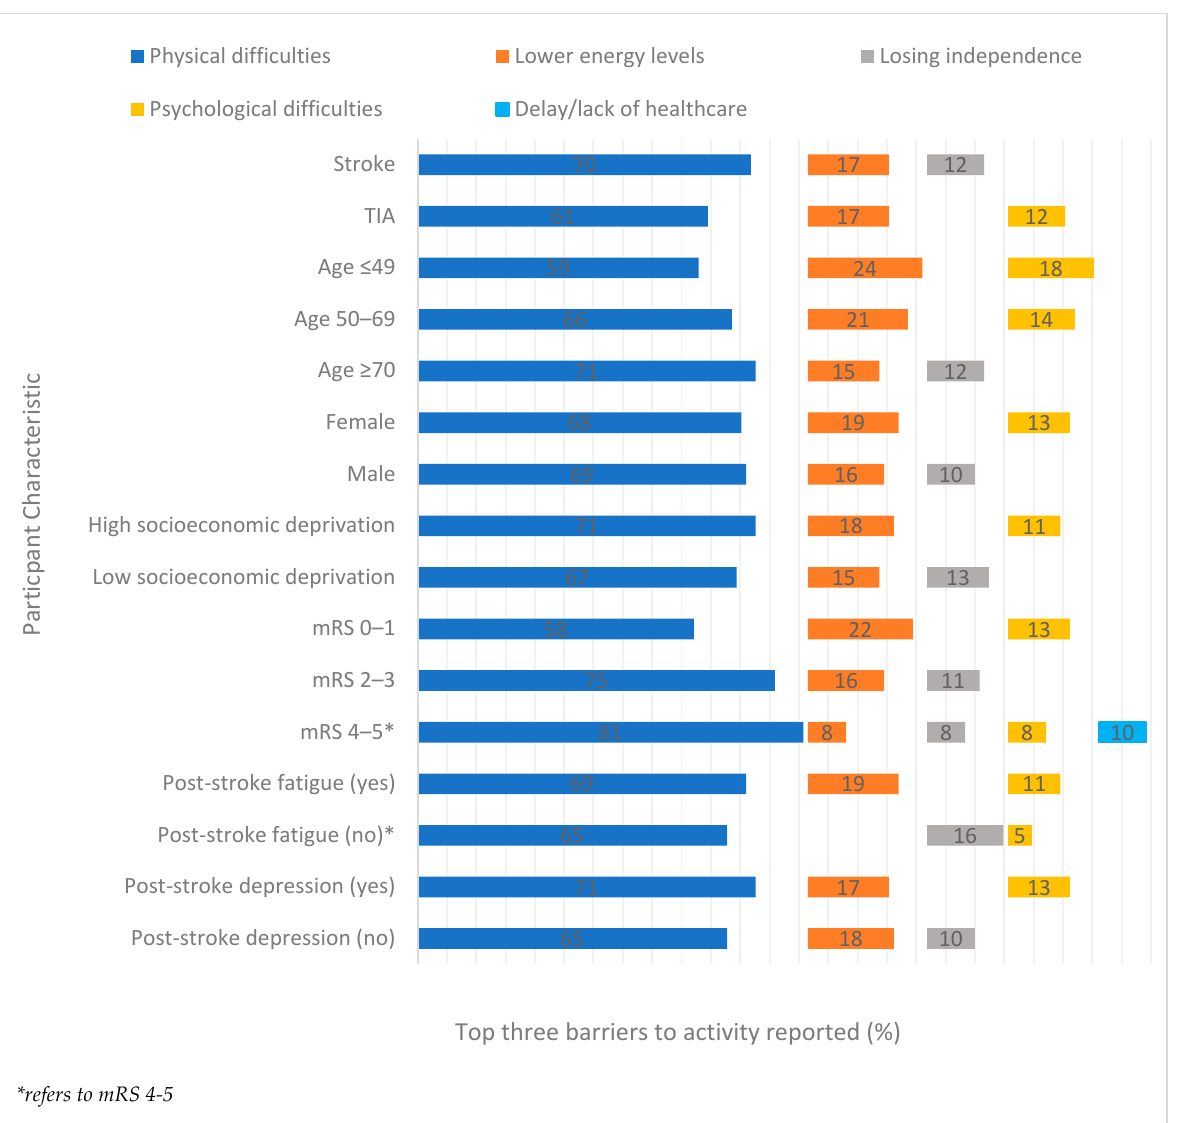
Top three barriers to activity reported (%)